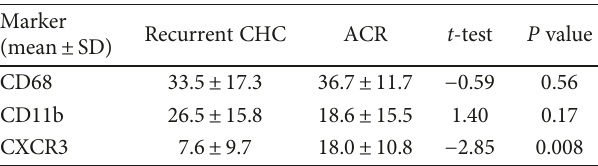
Table 5: Comparison between recurrent chronic hepatitis C (CHC) and acute cellular rejection (ACR) regarding the studied markers (CD68, CD11b, and CXCR3) in presence of